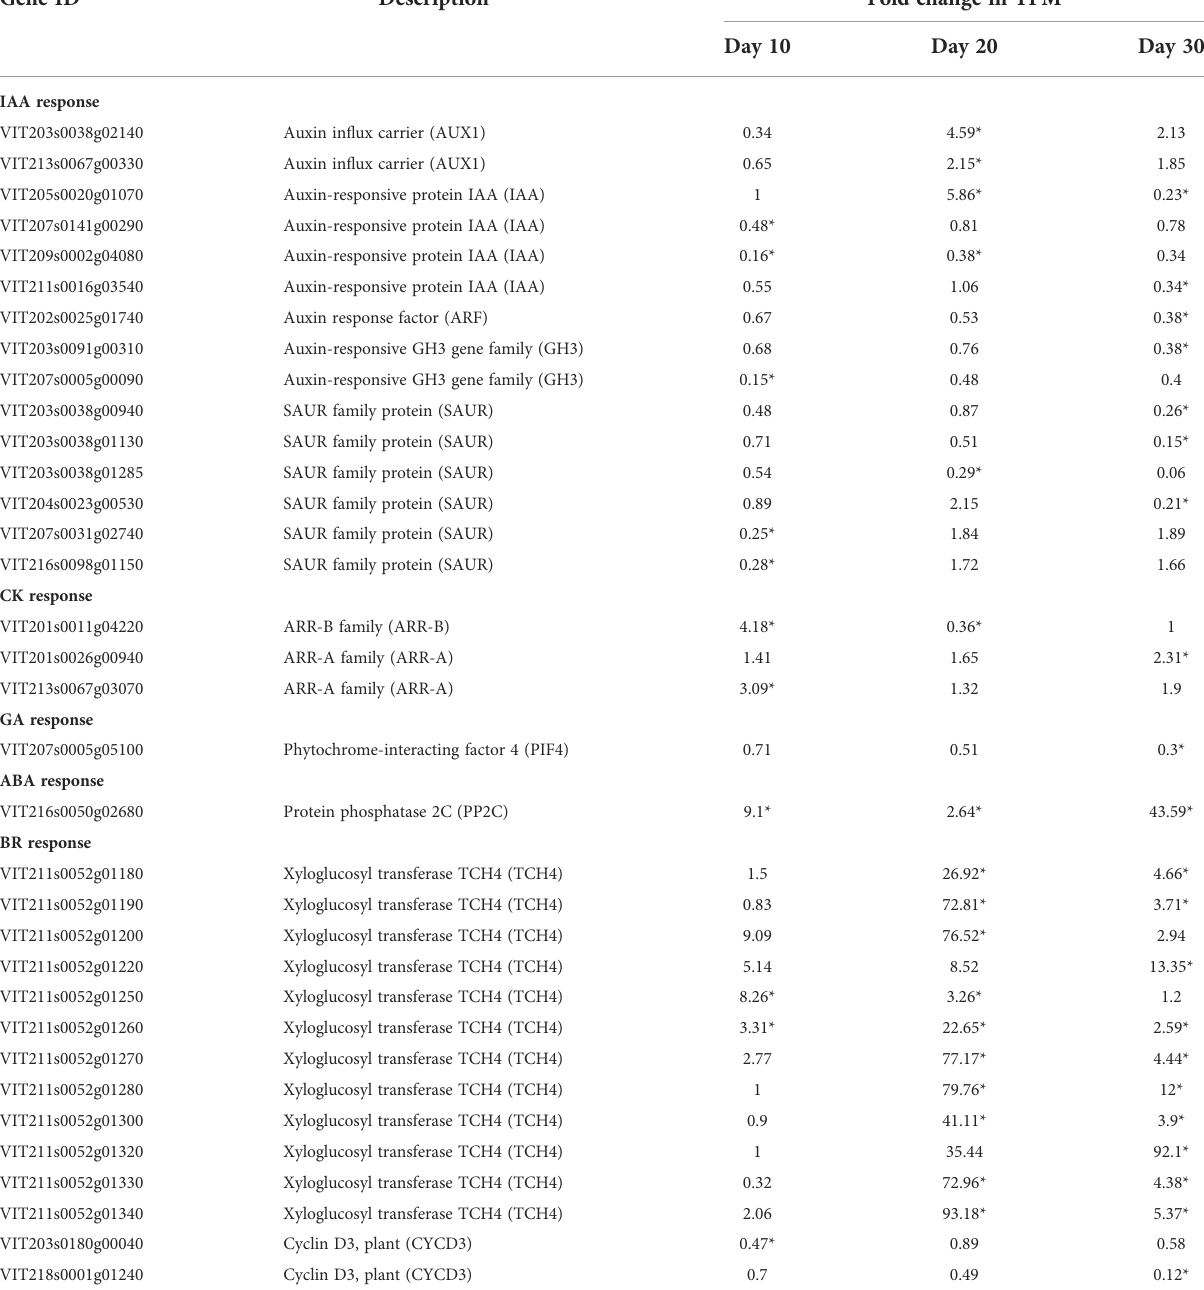
TABLE 2 Changes in the expression of DEGs related to plant hormone